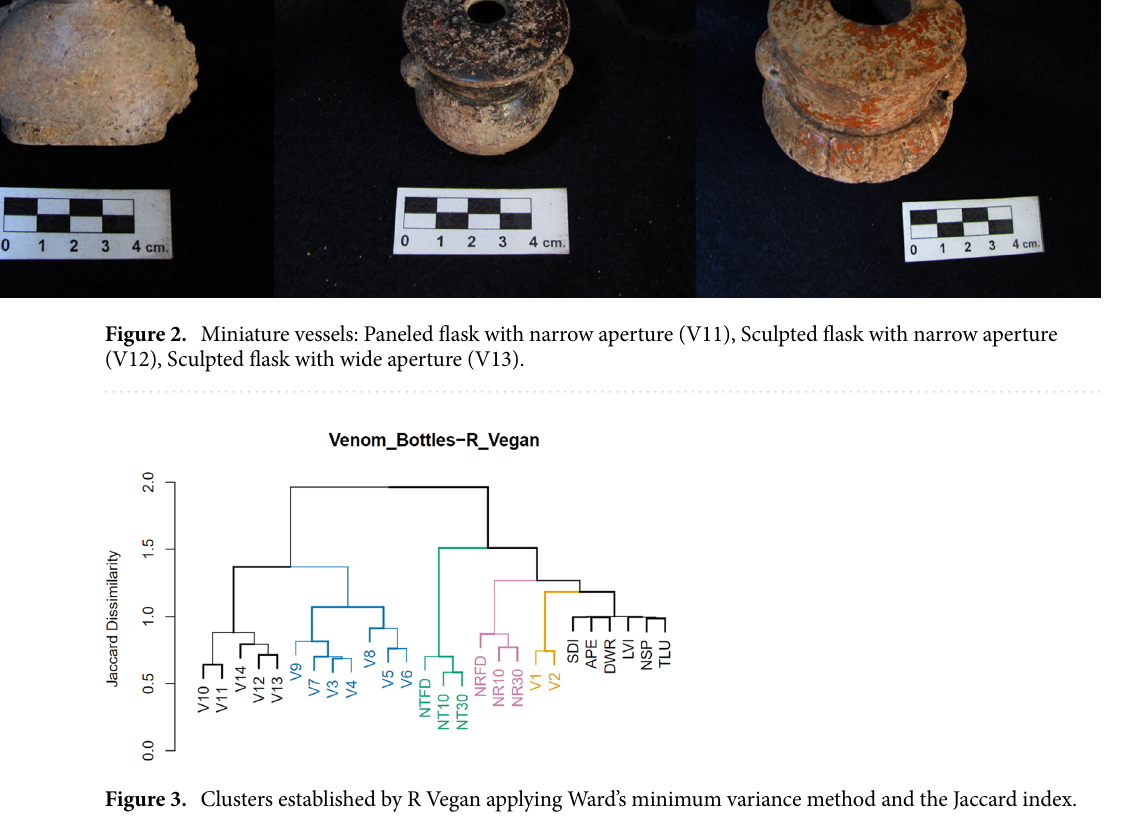
Figure 3. Clusters established by R Vegan applying Ward’s minimum variance method and the Jaccard